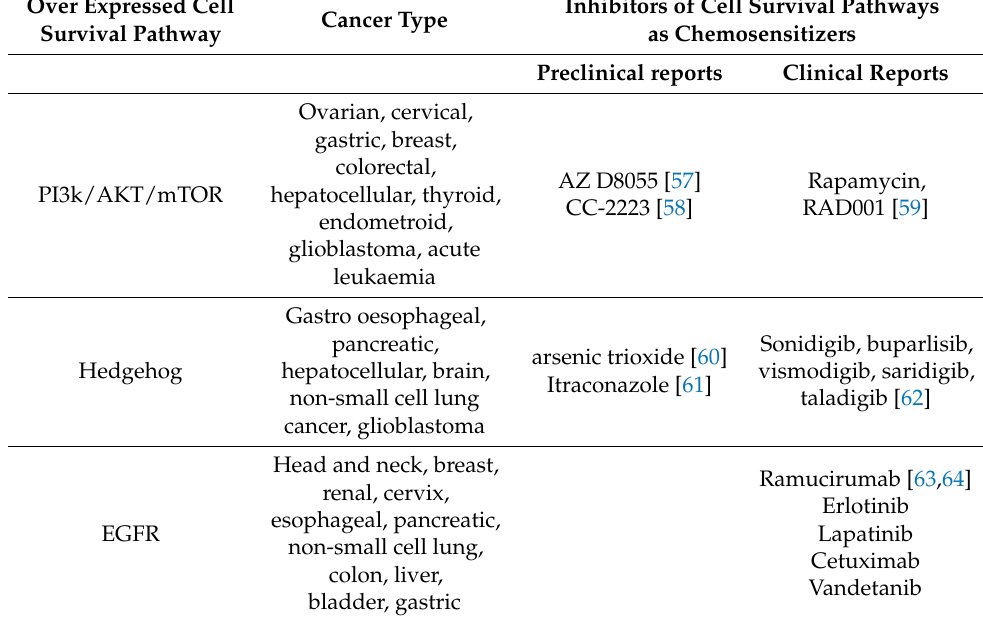
Table 4. Overexpressed cell survival pathways in MDR and their inhibitors as